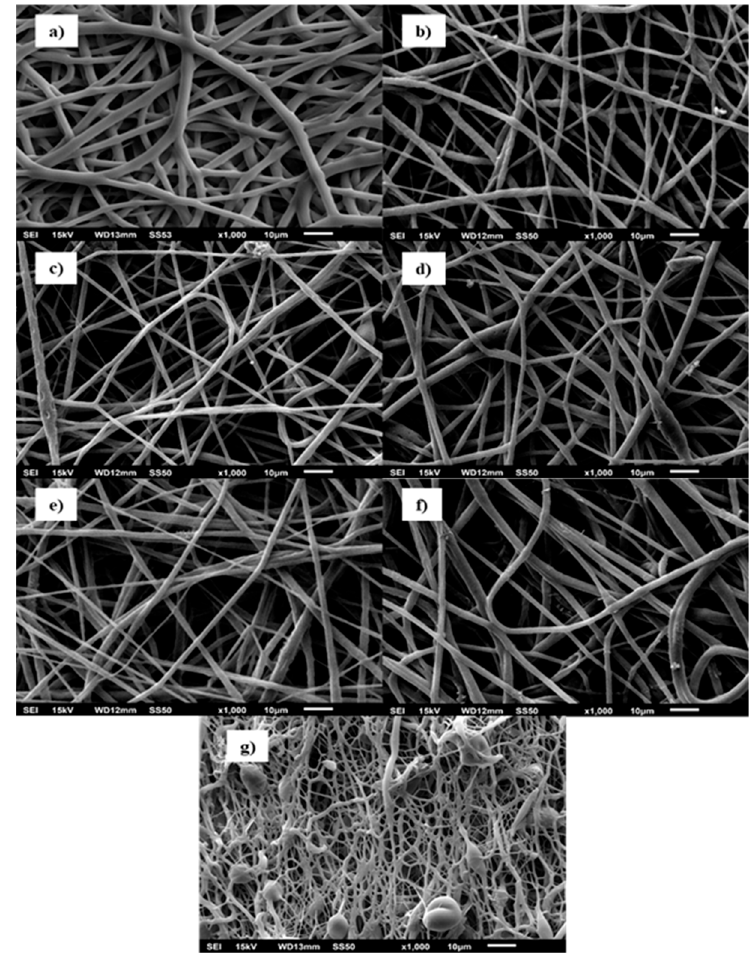
Figure 2. SEM images of ( a ) pure EVA, ( b ) EVA/0.1 wt % MWCNTs, ( c ) EVA/1.0 wt % MWCNTs, ( d ) EVA/1.5 wt % MWCNTs, ( e ) EVA/2.0 wt % MWCNTs, ( f ) EVA/2.5 wt % MWCNTs, and ( g ) EVA/3.0 wt % MWCNTs.